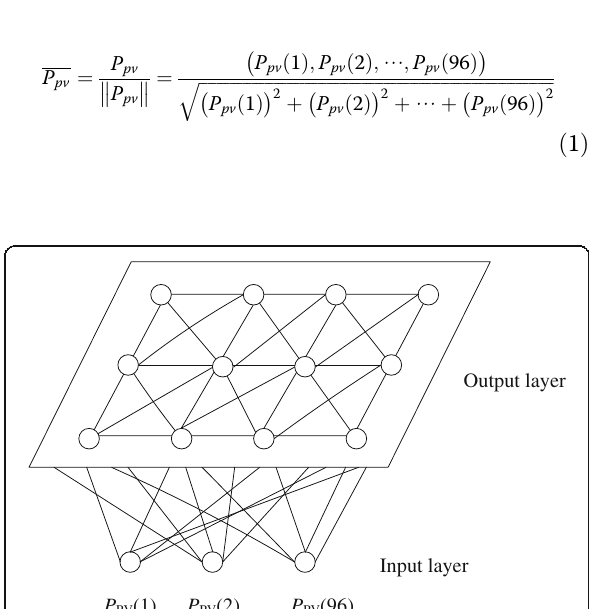
Fig. 1 PV output curve identification based on SOM